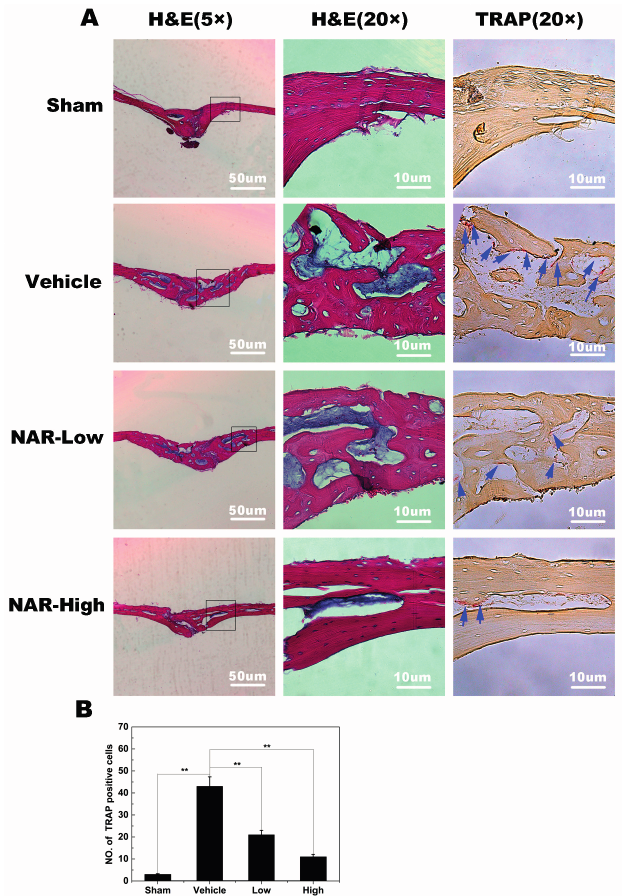
Figure 10. Histological and histomorphometric analysis of the effects of naringenin (NAR) on titanium (Ti) particle-induced mouse calvarial osteolysis. ( A ) Representative histological sections stained with hematoxylin and eosin (H & E) and stained for tartrate-resistant acid phosphatase (TRAP); ( B ) Histomorphometric analysis of the number of TRAP-positive multinucleated osteoclasts in the sections. ** p < 0.01.